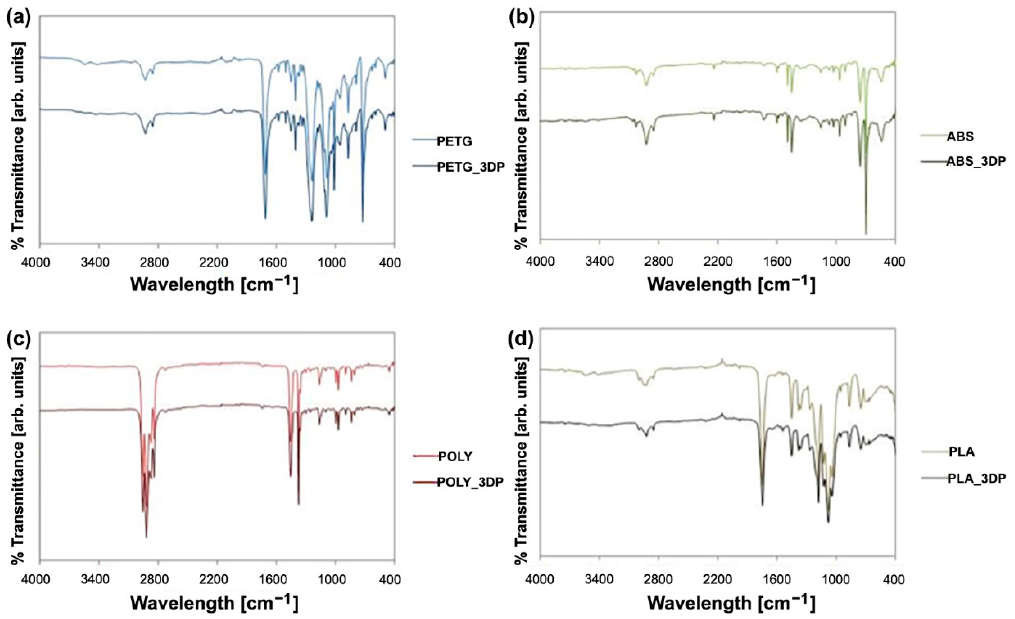
Figure 8. FT-IR bands of ( a ) PETG, ( b ) ABS, ( c ) PC, ( d )